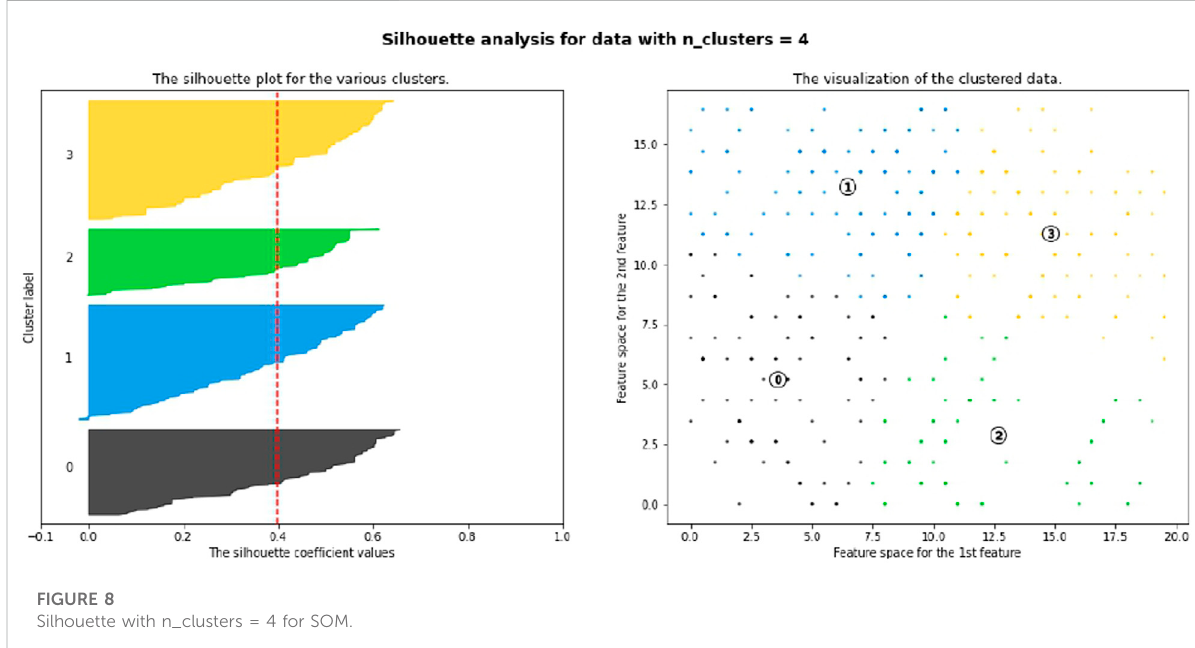
FIGURE 8 Silhouette with n_clusters = 4 for SOM.